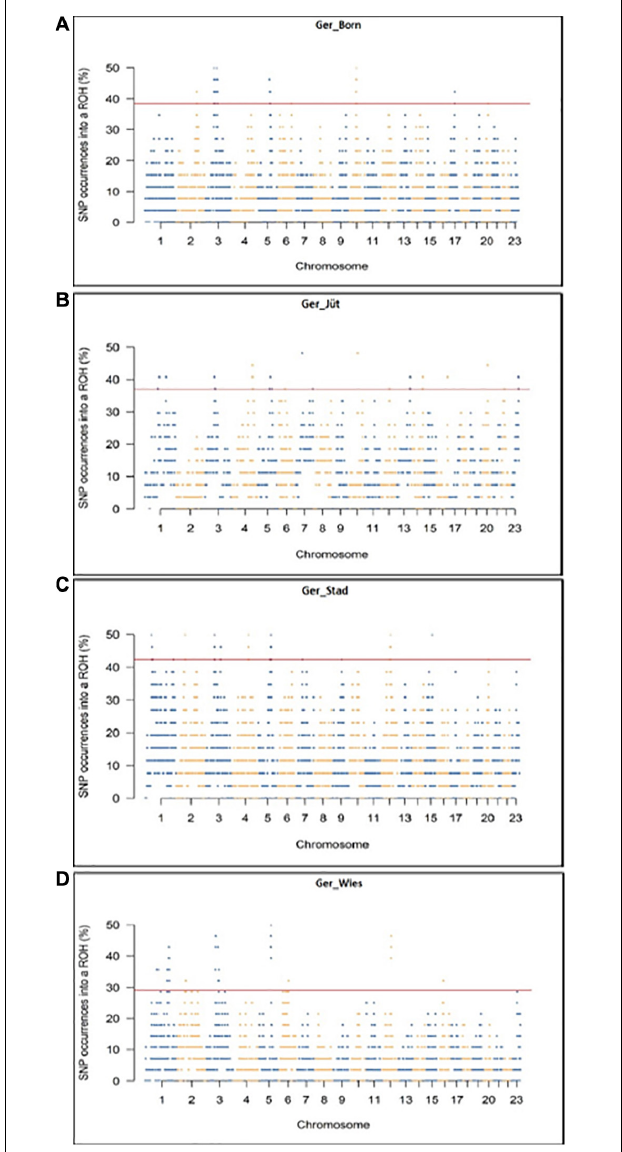
FIGURE 8 | Genomic distribution of ROH islands in German buffalo samples. The x-axis represents the SNP genomic coordinate chromosome-wise, and the y-axis visualizes the frequency (%) of overlapping ROH shared among individuals. The red line indicates the threshold to define the regions containing the top 1% of most common ROH-associated SNPs (ROH hotspots or ROH islands). Populations are presented as (A) Mecklenburg-Western Pomerania (Ger_Born), (B) Brandenburg (Ger_Jüt), (C) Lower Saxony (Ger_Stad), and (D) Saxony (Ger_Wies). Abbreviations and sample numbers are specified in Figure 3